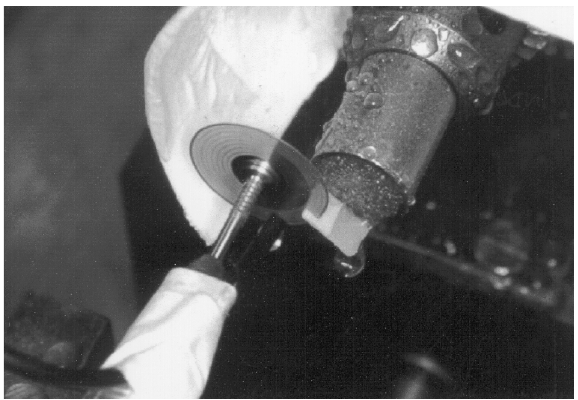
FIGURE 5- Cut for obtaining the